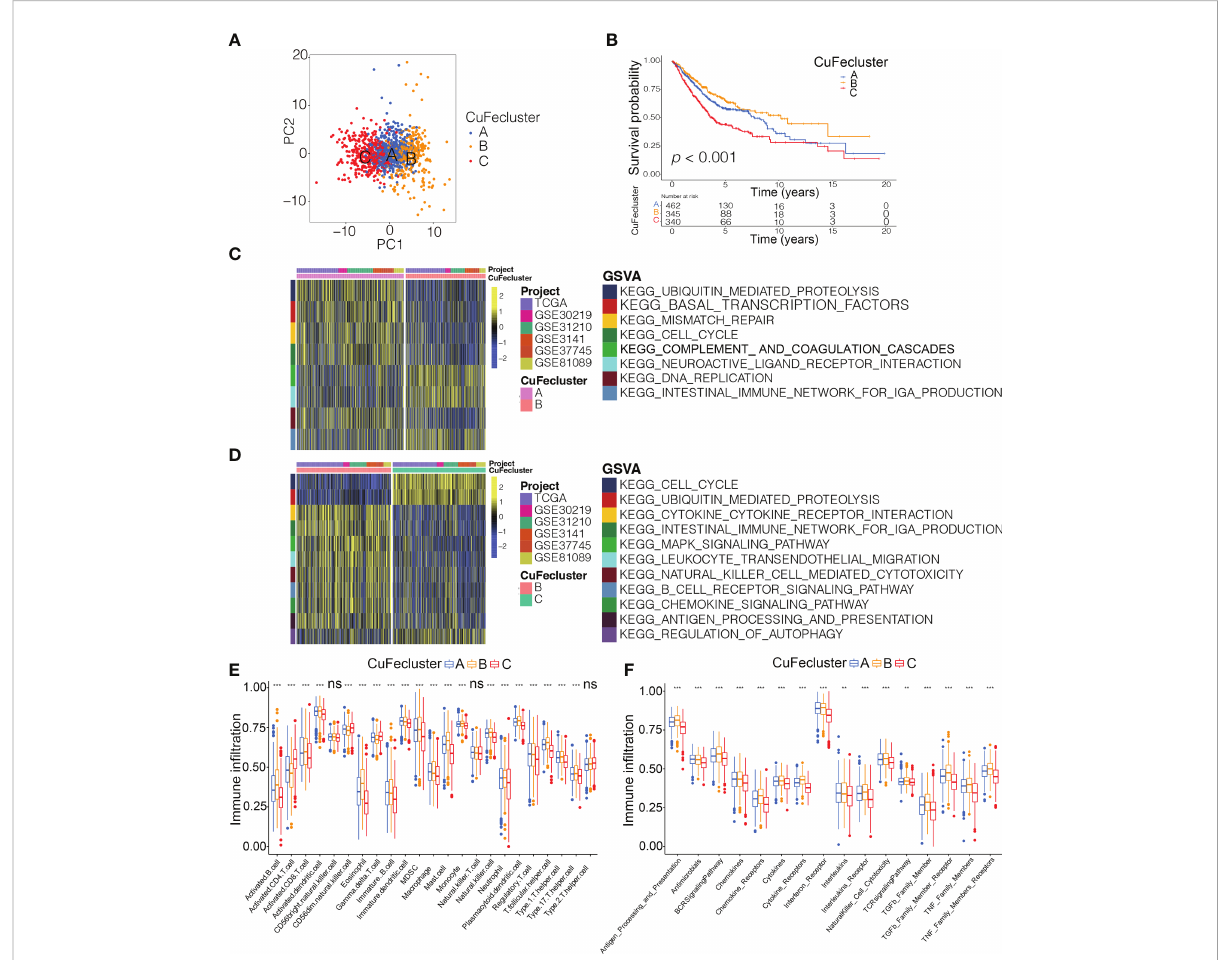
FIGURE 4 Tumor microenvironment cell in fi ltration characteristics and transcriptome traits in distinct CuFeclusters. (A) Principal component (PC) analysis revealed remarkable difference between three CuFeclusters from 6 cohorts (n = 1147). (B) Kaplan-Meier curves of survival for three patterns of three CuFeclusters based on LUAD patients from six cohorts (TCGA-LUAD, GSE30219, GSE31210, GSE3141, GSE37745, and GSE81089). (C, D) GSVA enrichment analysis shown the activation states of biological pathways in distinct CuFeclusters. The heatmap was used to visualize these biological processes, and yellow represented activated pathways and blue represented inhibited pathways. (C) CuFecluster A vs (B, D) CuFecluster B vs (C, E) Characteristics of immune in fi ltrating cells in different CuFeclusters. (F) Characteristics of immune responses in different CuFeclusters. GSVA, gene set variation analysis. ** p < 0.01, *** p < 0.001, ns, not signi fi